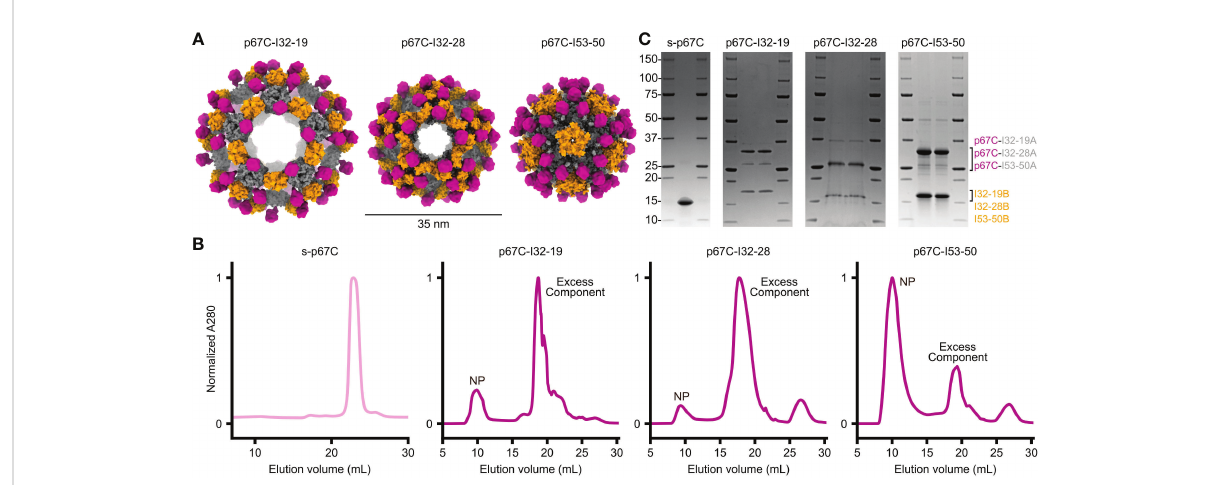
FIGURE 1 Design and puri fi cation of two-component nanoparticles displaying p67C co-expressed in vivo . (A) Design models of three distinct icosahedral nanoparticles displaying p67C, shown to scale. (B) Preparative size exclusion chromatography of s-p67C antigen and nanoparticles displaying p67C. Clear peaks were observed at the expected retention times for soluble antigen and nanoparticles (NP); excess component peaks were also observed for the nanoparticles. (C) SDS-PAGE of soluble p67C antigen and nanoparticles displaying p67C after puri fi cation by SEC. Bands were observed at the expected molecular weights for the two components of each nanoparticle. The left and right lanes for each nanoparticle are samples pre- and post-freeze/thaw,